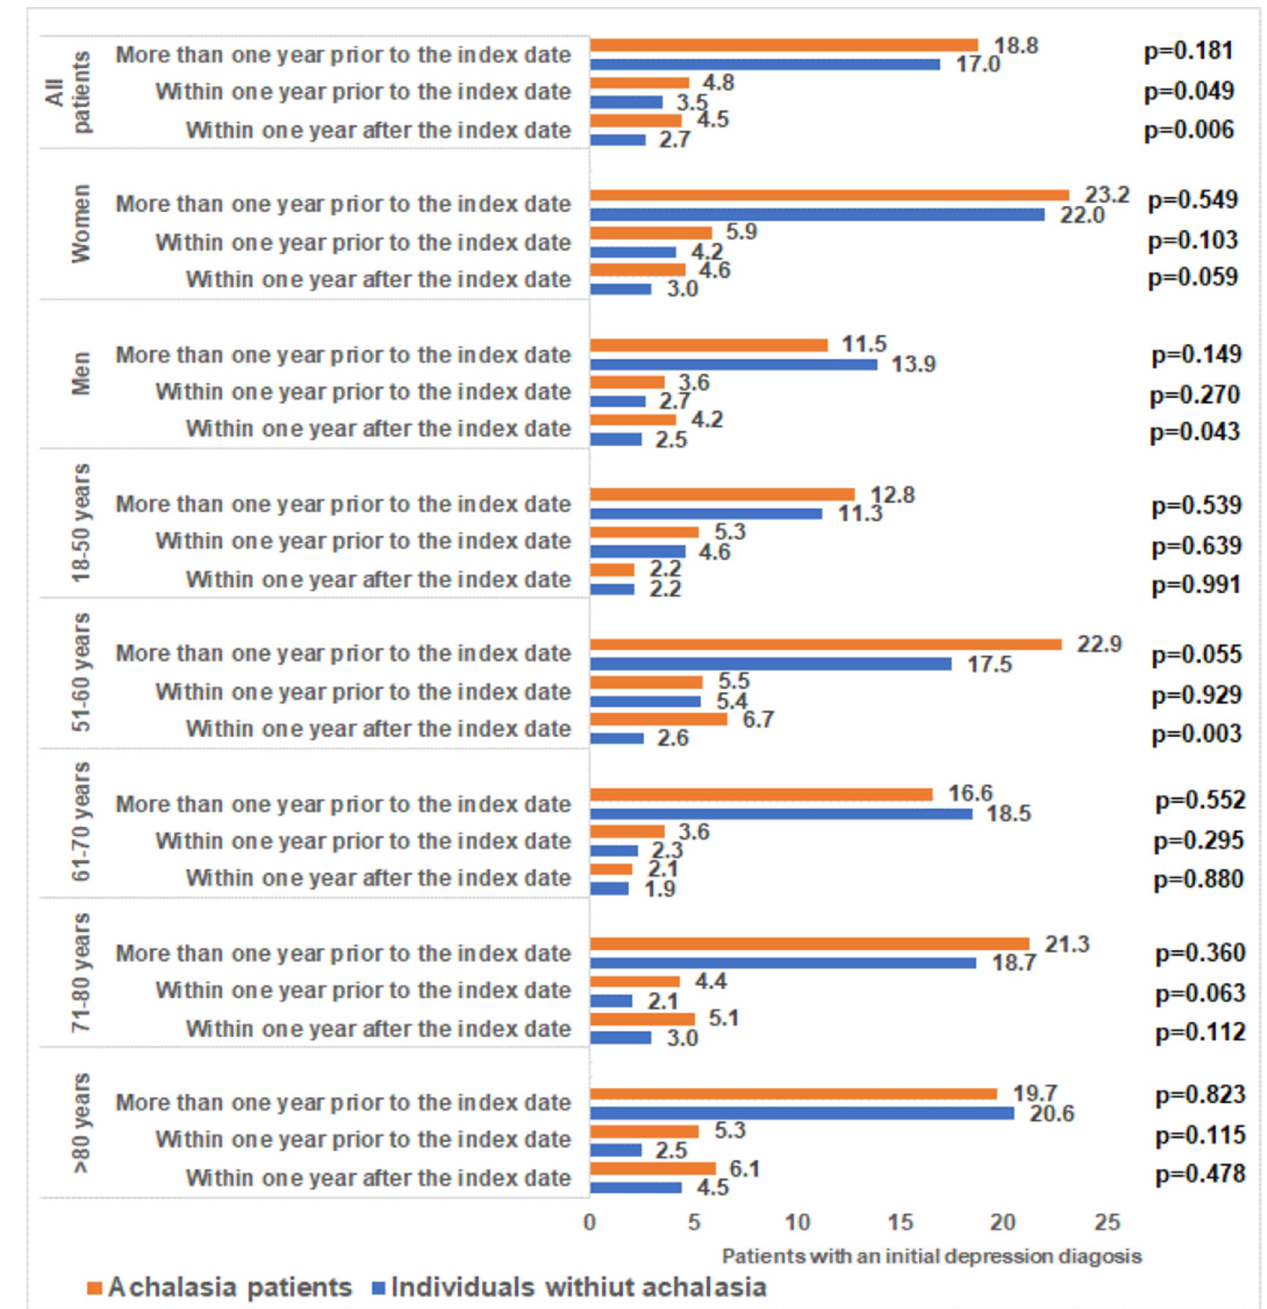
Fig 2. Cumulative incidence of documented depression among individuals with and without achalasia diagnoses followed in general practices.